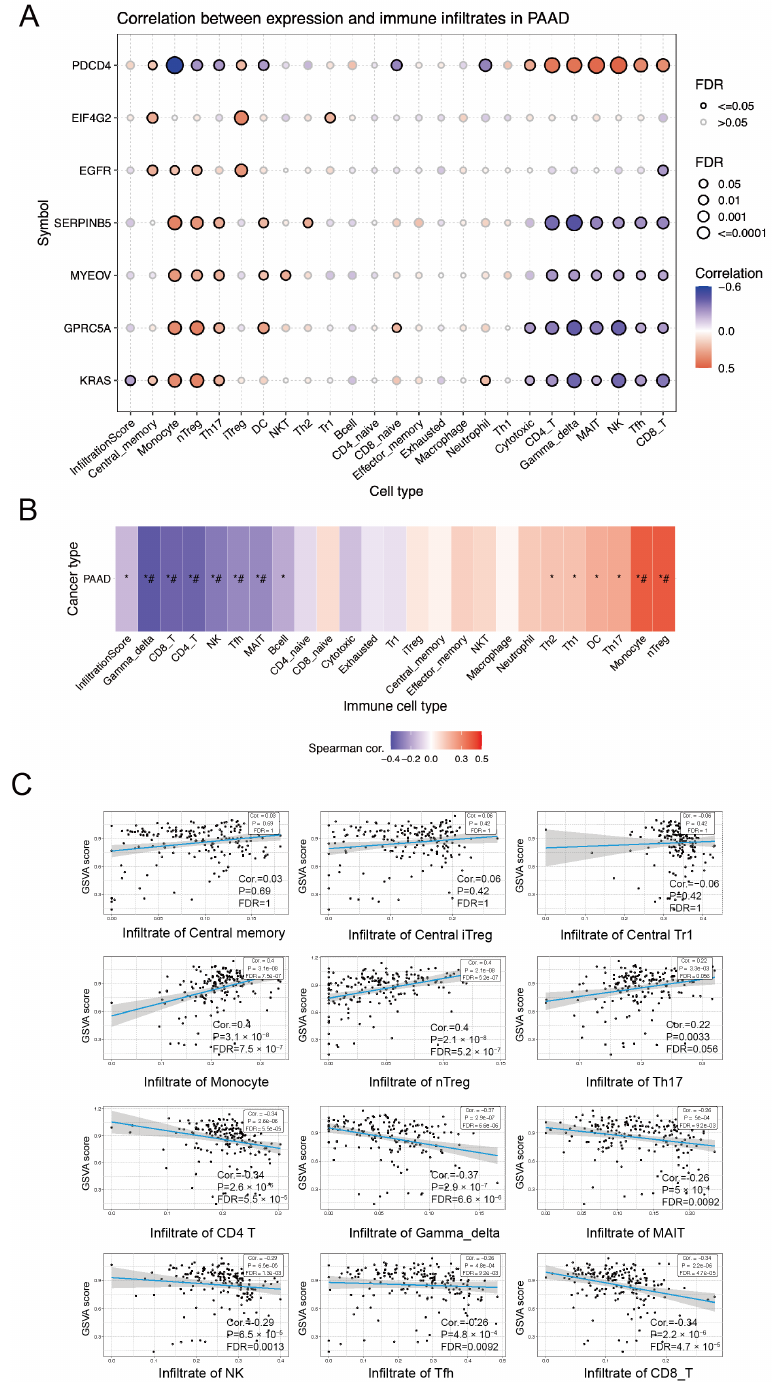
Figure 6. Immune infiltration analysis of genes associated with the MYEOV regulatory